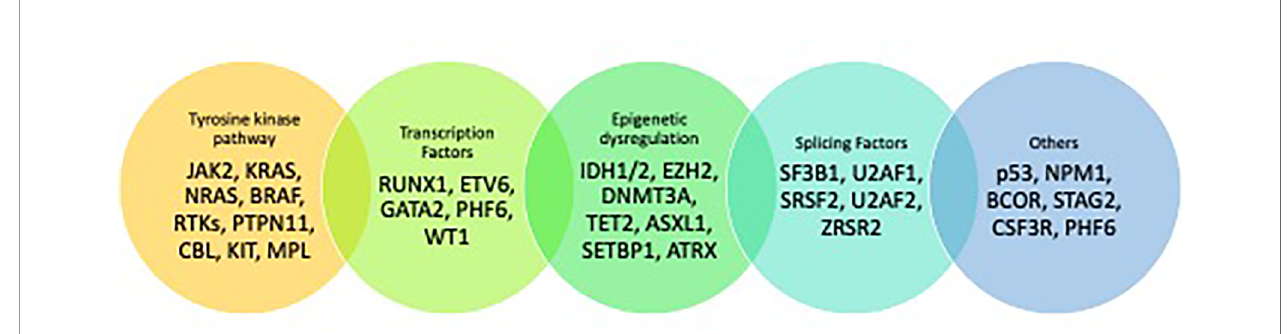
FIGURE 1 | Mutational landscape of